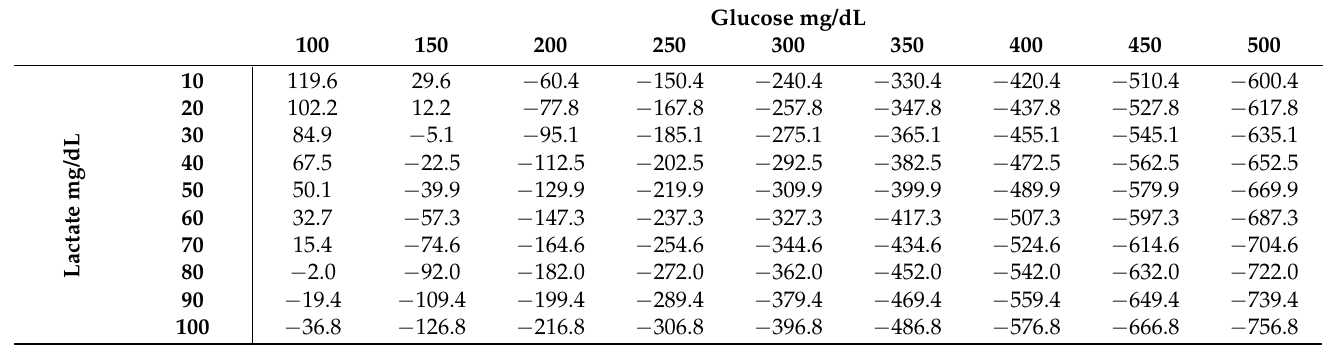
Table 3. Calculated net calorie balance per day (kcal/d) from CVVHD for different blood glu- cose (100–500 mg/dL) and lactate (10–100 mg/dL) concentrations with exemplary citrate dosage of